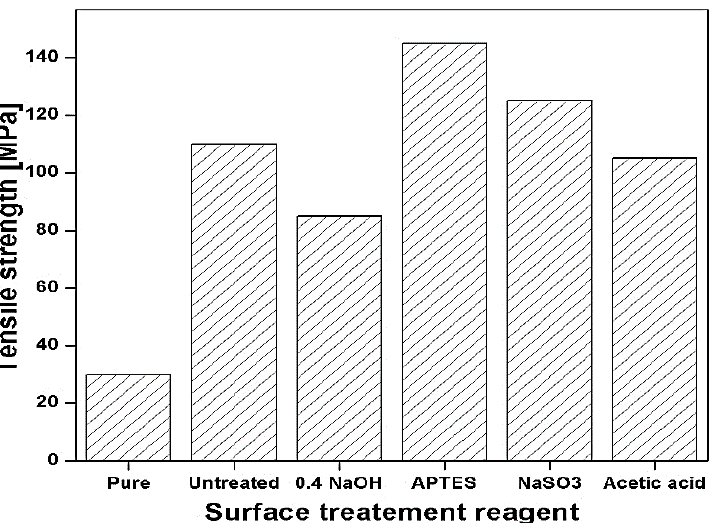
Figure 22. Tensile strength of neat epoxy, untreated fibre, and different surface modification reagents of the banana-reinforced polyester composite.